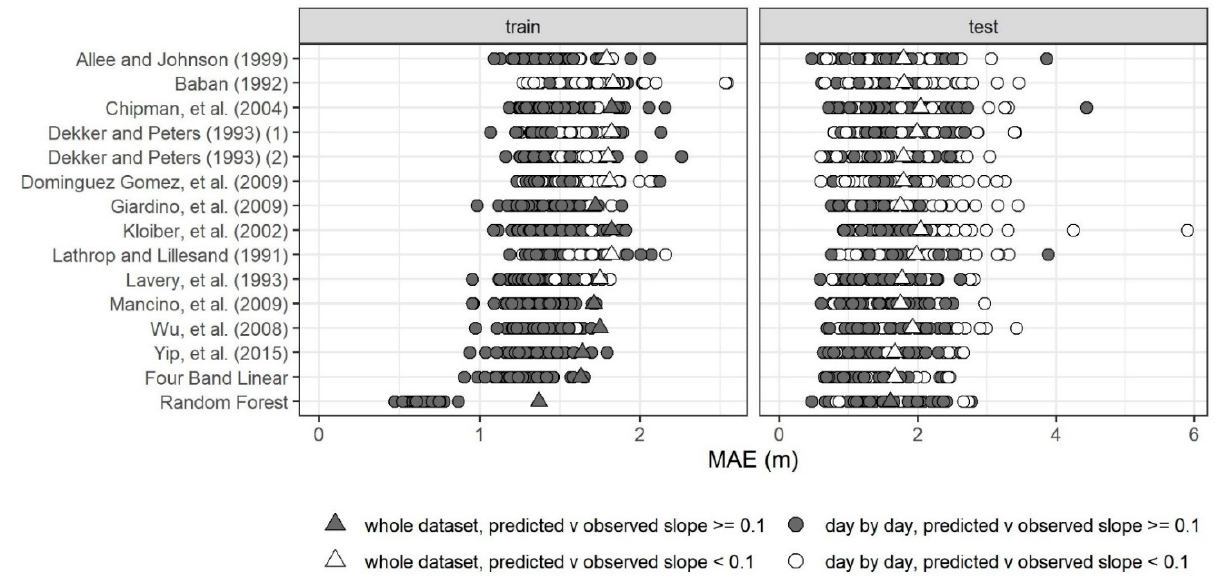
Figure 2. MAE for the training ( left ) and test ( right ) subsets, for the whole dataset (triangle) as compared to the day-by-day analyses (circles). Icons for the datasets are colored by the slope of the relationship between predicted and observed. Unfilled circles indicate a static predicted Secchi depth (predicted-observed slope < 0.1), gray fill indicates some response in the predicted Secchi depth such that there is a positive slope (>=0.1) in the relationship between predicted and observed Secchi depth. Note the difference in the x-axis scale between the two panels.